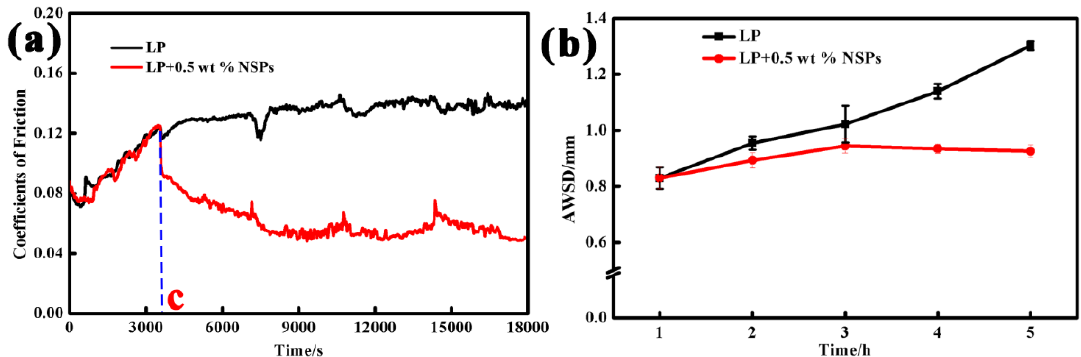
Figure 7. COFs ( a ) and the average spot diameter (AWSD; b ) of steel balls lubricated with LP + 0.5 wt % NSPs under different times.